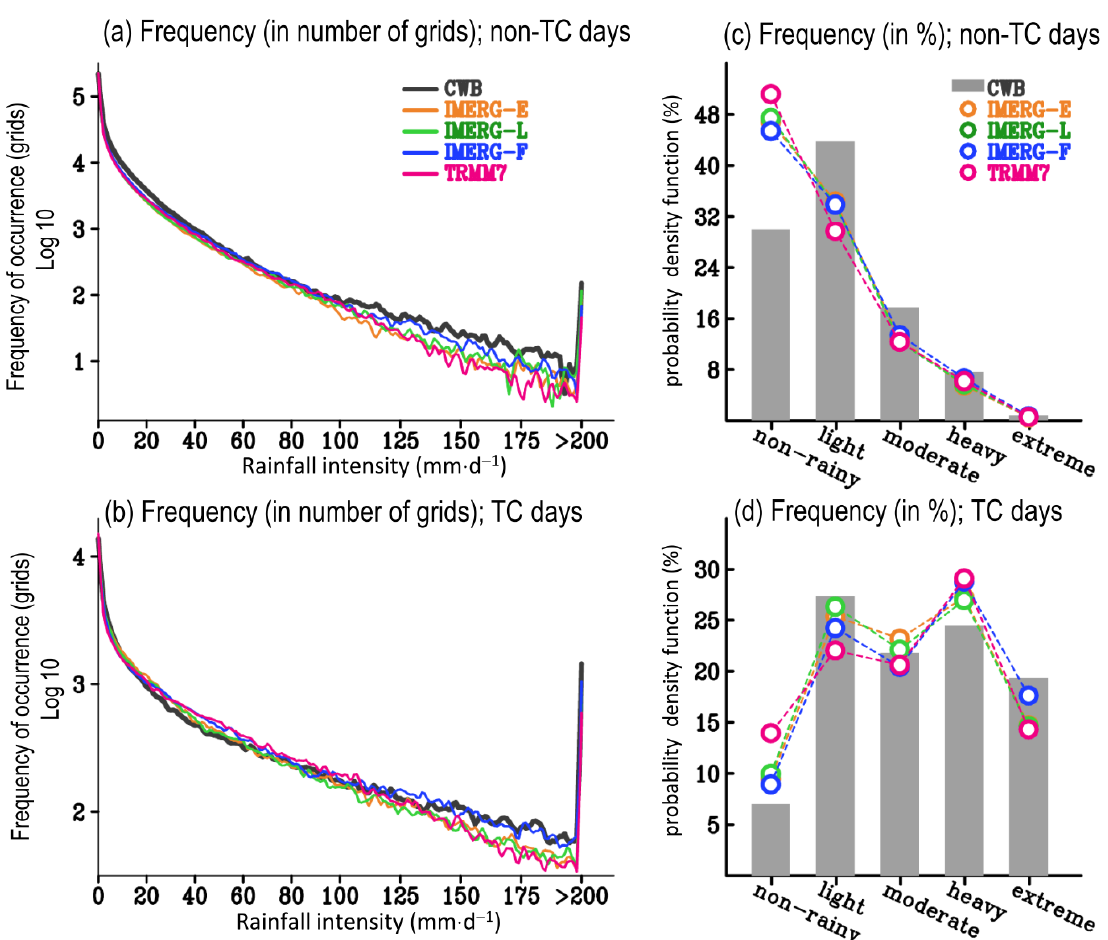
Figure 5. Rainfall occurrence frequency at different intensity thresholds over Taiwan for ( a ) 1942 non-TC days (sample size = 761,264 grids for 1942 days with 392 grids per day) and ( b ) 282 TC days (sample size = 110,544 grids). ( c , d ) corresponds to ( a , b ) but shows the probability density function for the occurrence frequency of grids with rainfall intensity at five different ranges, including non-rainy (0 – 0.1 mm d − 1 ), light (0.1 – 5 mm d − 1 ), moderate (5 – 20 mm d − 1 ), heavy (20 – 80 mm d − 1 ), and extreme (>80 mm d − 1 ).